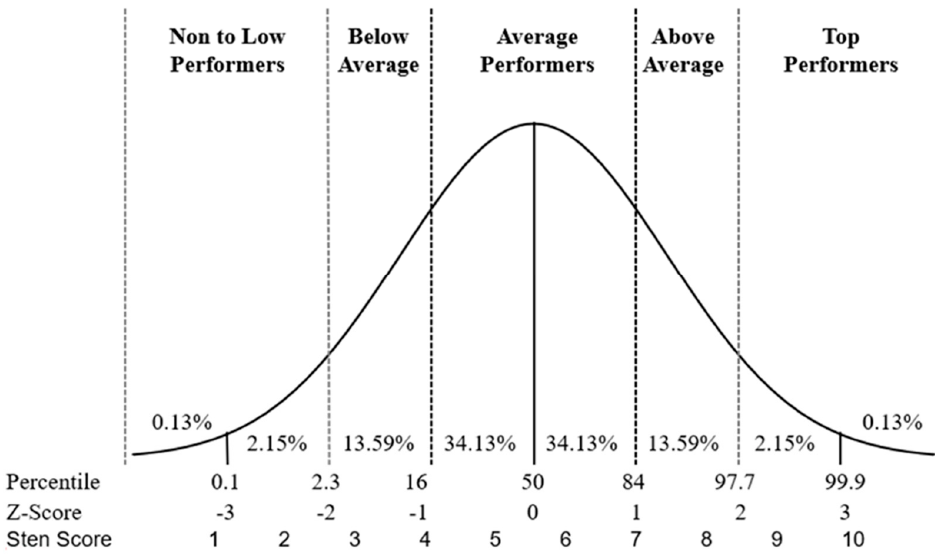
Figure 2. Example of a normal distribution and classifications for Z-score and